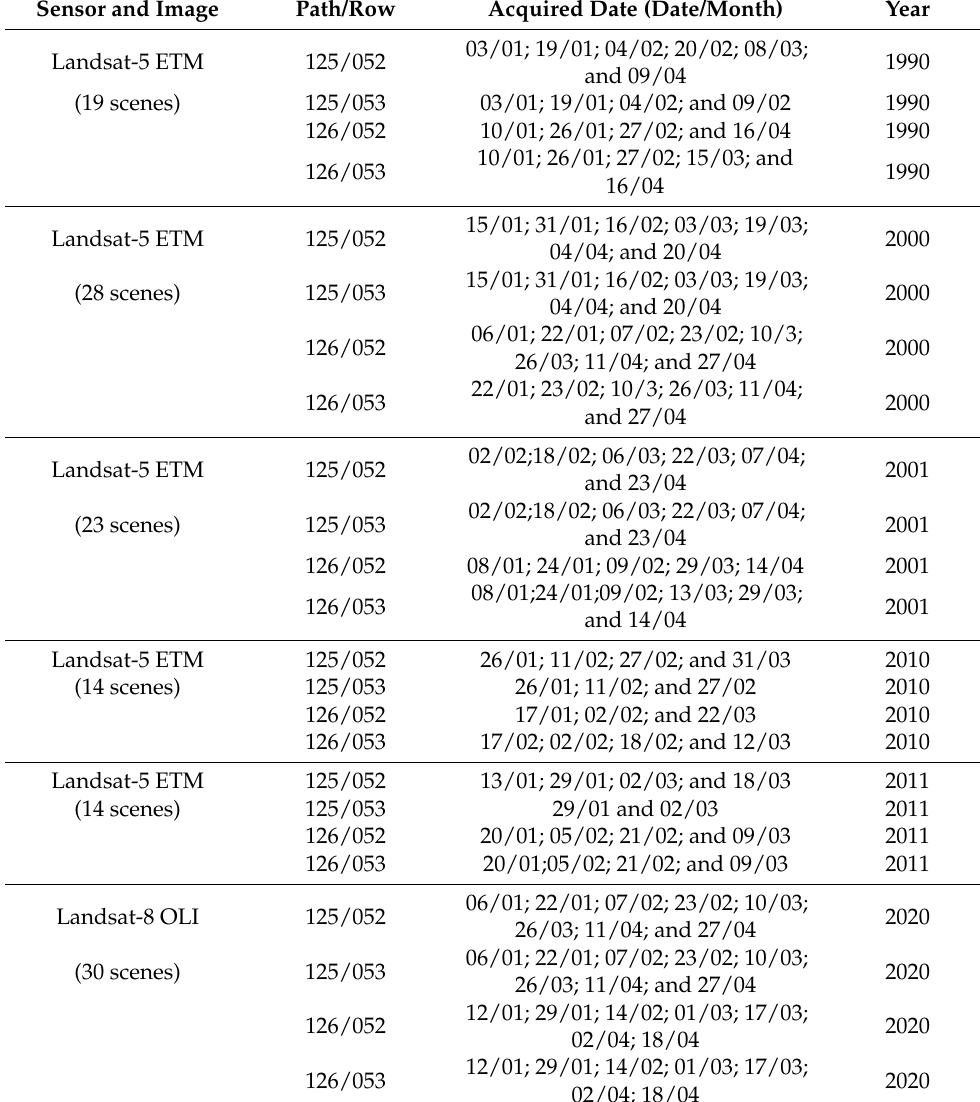
Table 1. Landsat surface reflectance images used to derive the land use and land cover (LULC) changes for the Dong Thap Muoi area. ETM: Enhanced Thematic Mapper. OLI: Operational Land